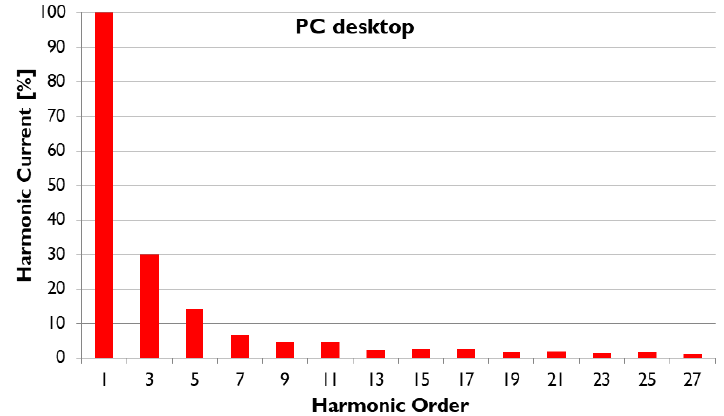
Figure 5. Current spectrum of the PC desktop.